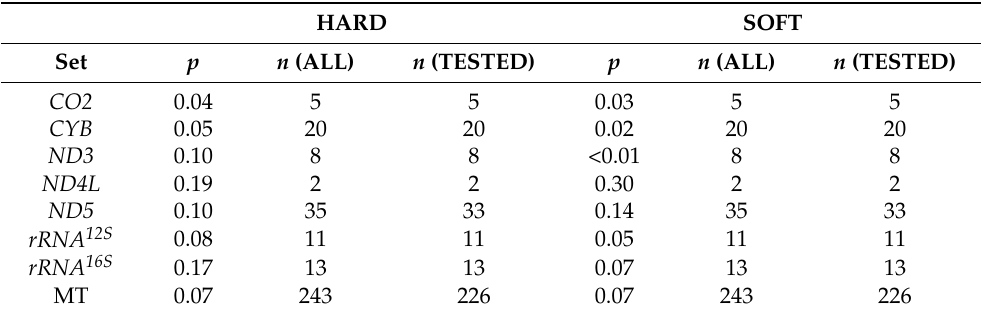
Table 4. MT-gene-based associations with HARD and SOFT CAD phenotypes. MT = mitochondrion; n (ALL) = the number of MT-SNVs in the region; n (TESTED) = the number of MT-SNVs from the region considered in the gene-based test; MT =